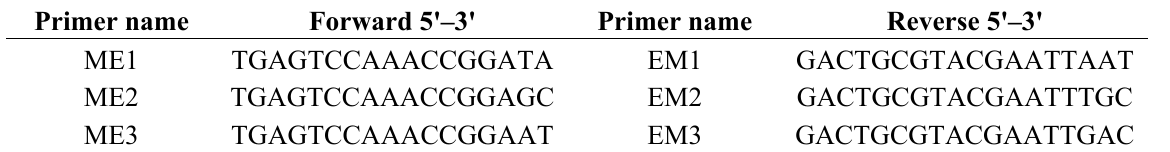
Table 7. Name and sequence of SRAP primers